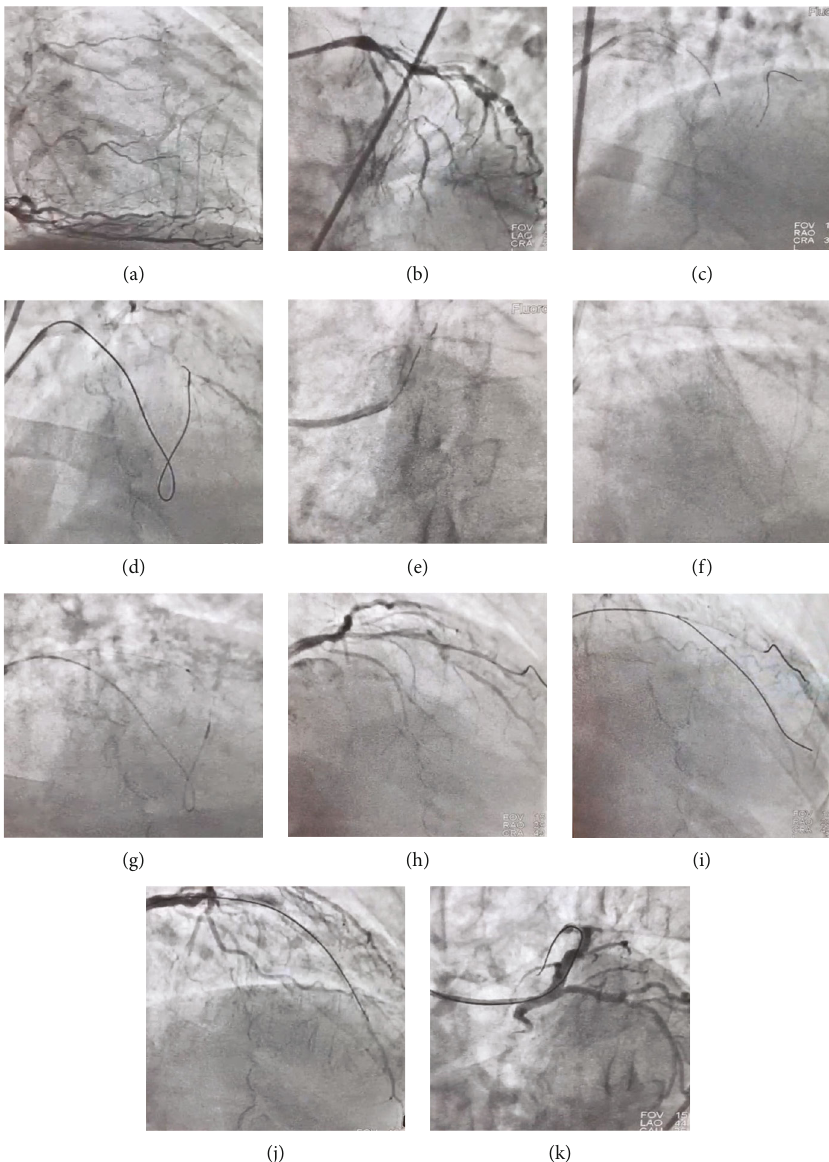
Figure 1: (a – k) Selective right coronary artery injection shows well-developed collateral vessels, which fi ll the left anterior descending artery (LAD) retrogradely (a). Selective left main injection shows a totally cut LAD at the midpart (at the trifurcation point) with an ambiguous cap and a lengthy occluded segment, with a good runo ff (b). A large proximal septal branch fi lls the LAD antegradely. Hence, with the aid of a SUOH 03 wire (ASAHI Intecc Medical) and a Caravel 150 cm microcatheter (ASAHI Intecc Medical), septal sur fi ng is performed (c). Once the wire reaches the distal cap, the microcatheter is advanced over it (d). Thereafter, with a Gaia second wire (ASAHI Intecc Medical), several attempts are made to puncture the distal cap but to no avail. Subsequently, with a Gladius wire (ASAHI Intecc Medical), the distal cap is crossed, the wire is tipped into the guide catheter, and the same microcatheter is passed over it (e). In this stage, a SION blue wire (ASAHI Intecc Medical) is advanced antegradely toward the retrograde microcatheter ( “ reverse tip-in ” ), creating a loop between the LAD and the septal branch (f). Afterward, the microcatheter is retracted, and predilation and LAD preparation are done antegradely (g). The wire is positioned antegrade to the diagonal branch at the site of the trifurcation (h). Under the guidance of a dual- lumen SASUKE microcatheter (ASAHI Intecc Medical) over the SION blue wire, the Gaia second wire is advanced toward the LAD (i). The LAD is then predilated, and stenting is performed, yielding good fi nal results (j,